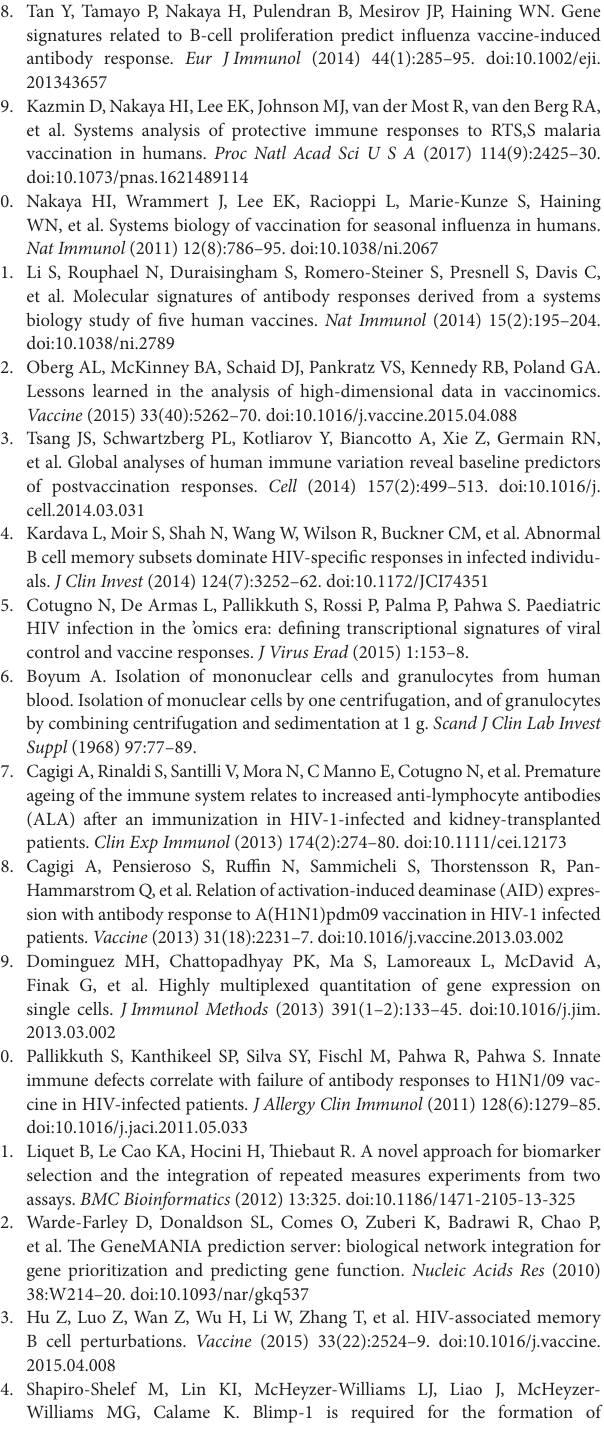
TaBle s2 | Differentially expressed genes (DEGs) between cell subsets in HIV, healthy controls (HC), R and NR. Table shows DEGs in all groups (HIV, HC, HIV NR, HIV R) when subsets were compared. In the table, cells are highlighted in orange when p values were < 0.01 and not highlighted when p value < 0.05. Outlined cells define an opposite relation compared to the one in the headline.